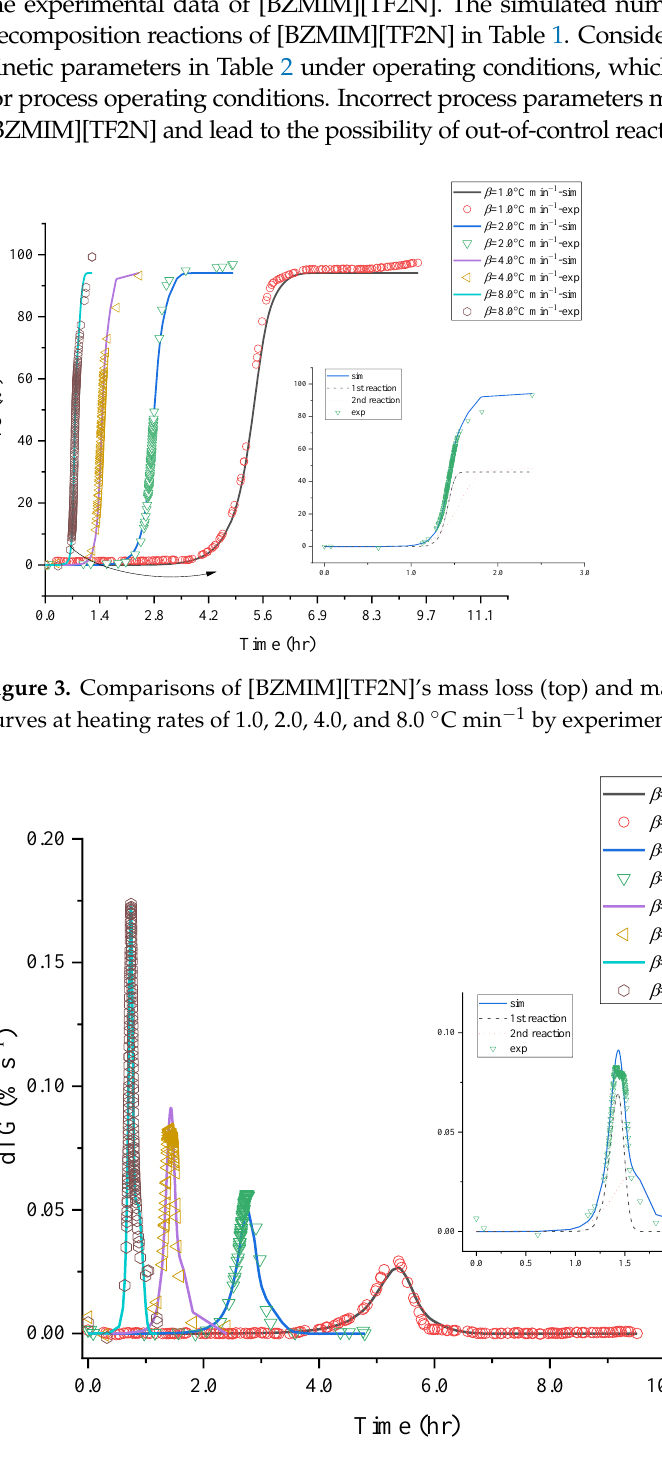
Figure 2. Mass loss and mass loss rate of [BZMIM][TF2N] by TGA results with different heating rates at 1.0, 2.0, 4.0, 8.0, and 10.0 °C min −1 .